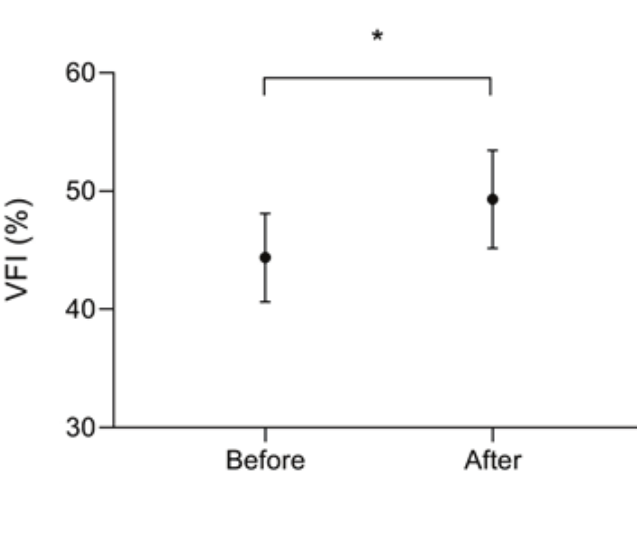
Figure 1. VFI changes before and after using the reversed Galilean telescope. Data are presented as Mean ± SEM ( n = 52 subjects). *Denotes a significant difference.